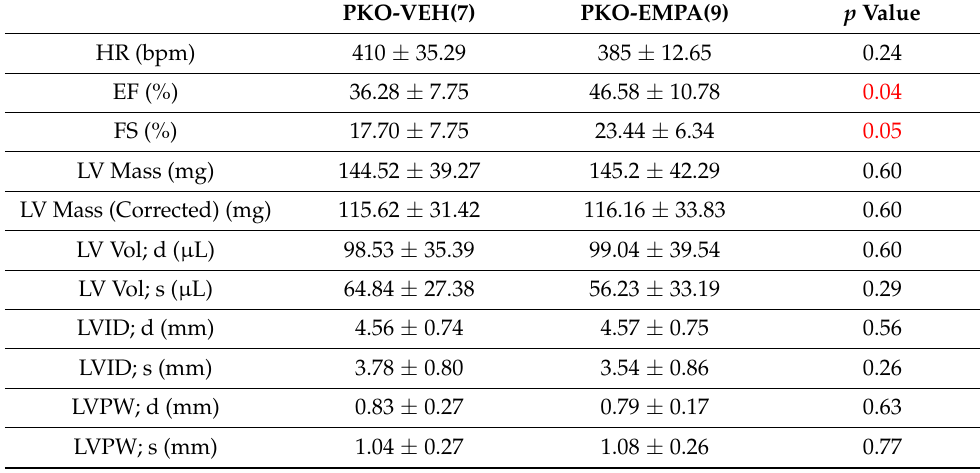
Figure 3. EMPA limits infarct-mediated development of adverse remodeling in Parkin knockout mice. Age-matched WT mice underwent PCAL and 2 h later were given vehicle (0.5% w/v hydroxyethyl cellulose) or EMPA (10 mg/kg/day) via oral gavage daily. ( A ) Schematic of the protocol; ( B ) representative 4× and 20× magnification of heart sections stained with H&E of infarct border zone from 3 days after PCAL to show infiltration of immune cells; ( C ) representative 4× and 20× magnification of heart sections with Masson Trichrome staining 14 days after PCAL showing fibrosis. Table 2. Assessment of cardiac function and post–infarction cardiac remodeling by echocardiography 14 after MI in PKO mice treated with EMPA (10mg/kg/day) or